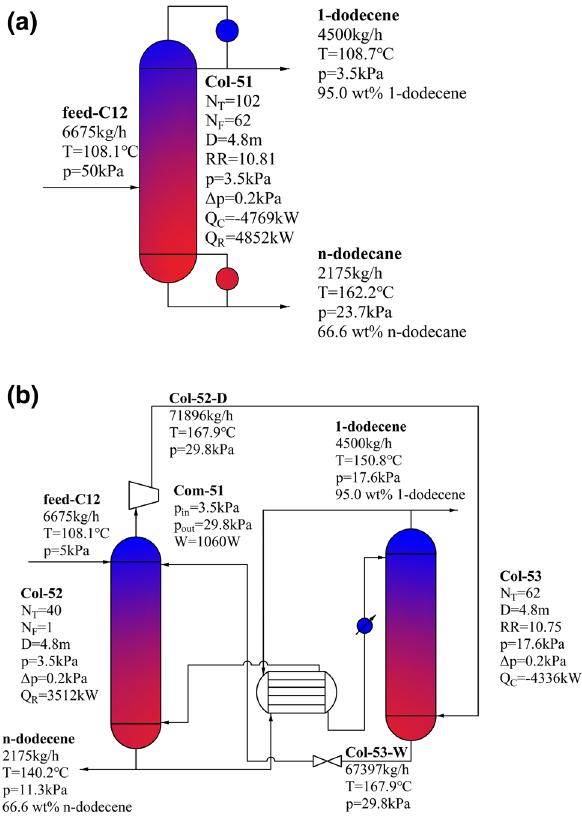
Fig. 6 Process and simulation results of the C12 α -olefins